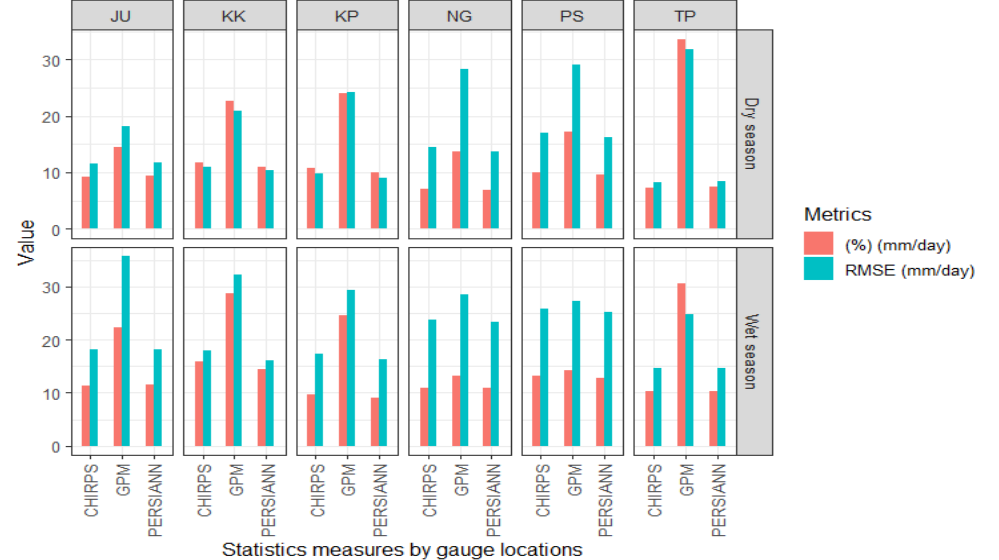
Figure 6. Errors RMSE and NRSME variability of each satellite products at the gauges. Table 5. Summary of quantitative accuracy measures from three satellite rainfall products. Data calculated with outliers included.